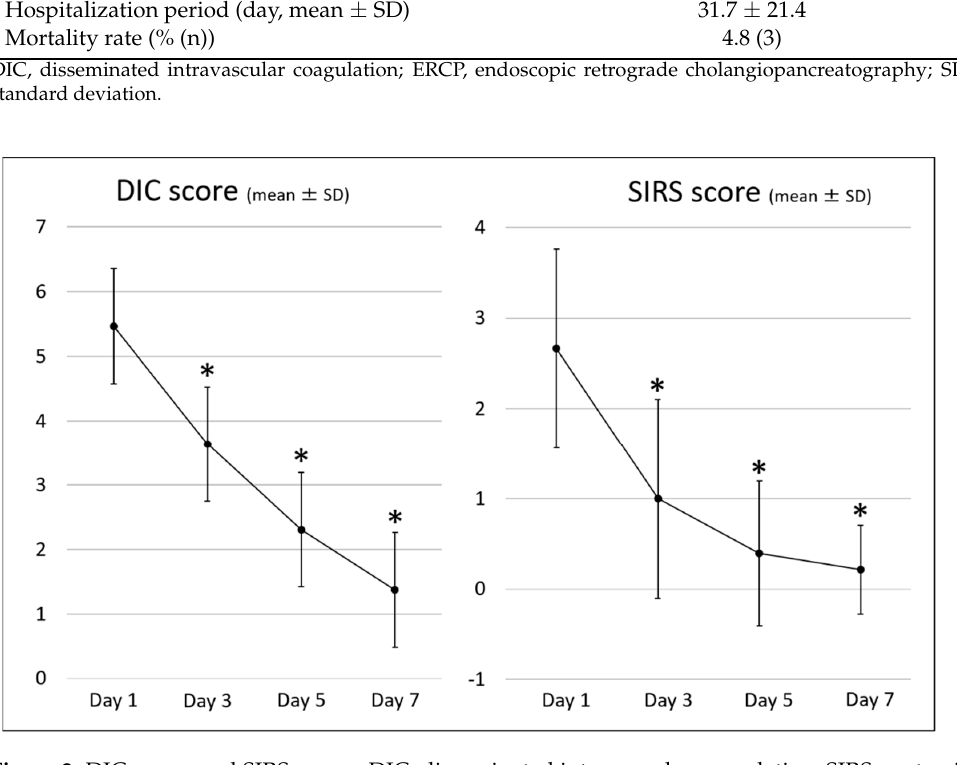
Figure 2. DIC scores and SIRS scores. DIC, disseminated intravascular coagulation; SIRS, systemic inflammatory response syndrome; * p < 0.05 vs. baseline.